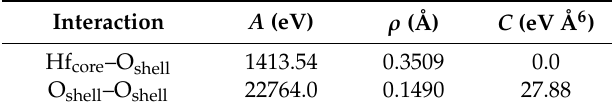
Table 3. Interionic potentials obtained from a fit to the HfO 2 structure [17].